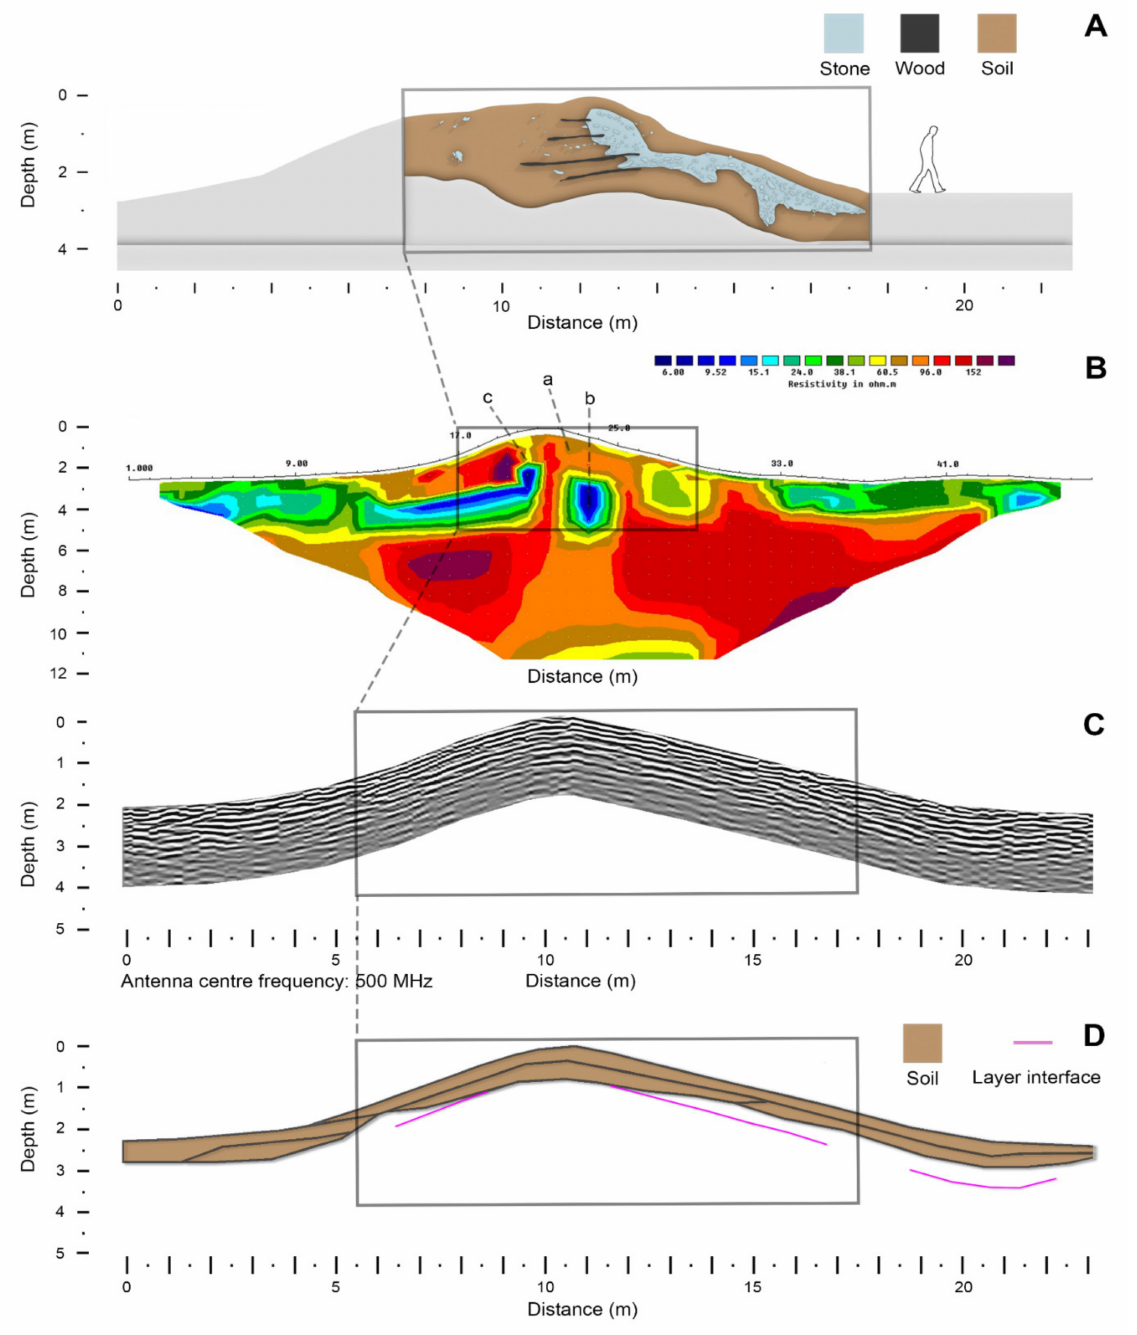
Figure 10. Mikulˇcice-Valy. ( A ): Profile of the hillfort’s fortification based on the results of archaeo- logical excavation ([9], Figure 106). ( B ): Electrical resistivity tomography model in double dipole configuration. ( C ): GPR vertical time/depth radarogram from an antenna with 500 MHz centre frequency. ( D ): Interpretation of the GPR